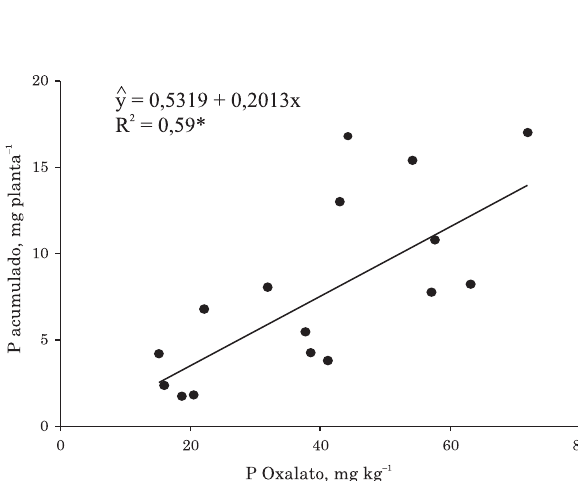
Figura 2. Relação entre os teores de fósforo extraídos pela resina de troca aniônica (RTA) e Olsen e as quantidades de fósforo acumulado pelo arroz nas amostras dos solos: Planossolo, Gleissolo, Luvissolo, Vertissolo e Chernossolo, nas três doses de fósforo (0; 19,6 e 39,3 mg kg -1 de P no solo).